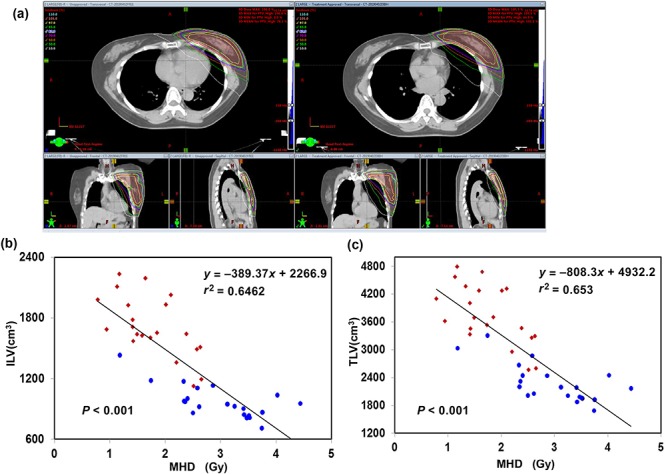
Dosimetric evaluation of the DIBH plan compared with the FB plan. (a) IMRT treatment plans with and without DIBH gating (dose: color curve; CTV: yellow curve; PTV: red colorwash). Left side: IMRT treatment planning with FB; right side: the same patient planned using gated breathing with DIBH. (b) Ipsilateral lung volume (ILV) and (c) total lung volume (TLV) plotted against mean heart dose according to the CTFB plan (blue) and the CTDIBH plan (red). ILV and TLV showed good negative linear correlations with mean heart dose for all patients. DIBH = deep inspiration breath-hold, FB = free-breathing, IMRT = intensity-modulated radiotherapy, CTV = clinical target volume, PTV = planning target volume, MHD = mean heart dose.